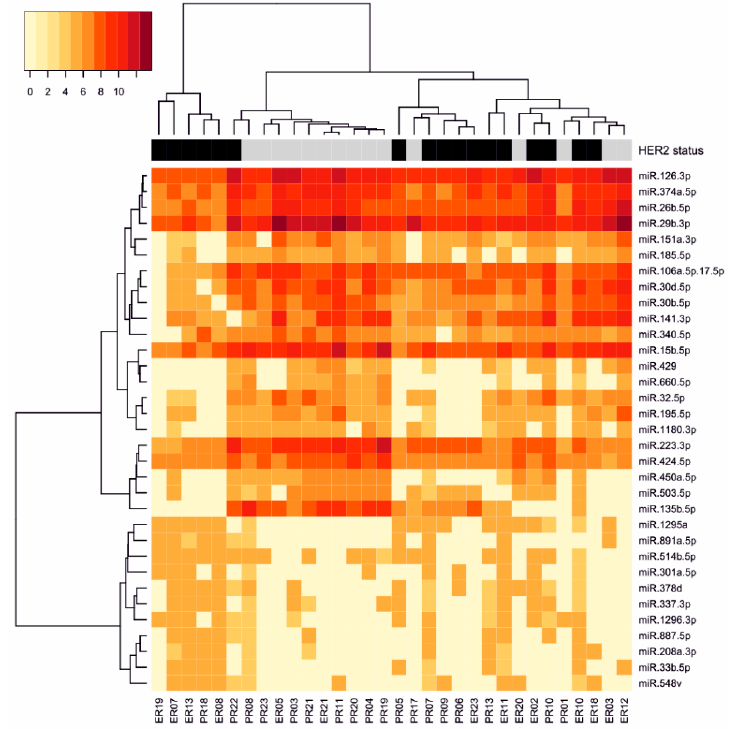
Figure 1. Heatmap depicting expression of 33 HER2-associated miRNAs among analyzed single hormone receptor-positive breast tumors; color legend indicates HER2 status; HER2-negative cases are marked in grey, HER2-positive cases are marked in black.